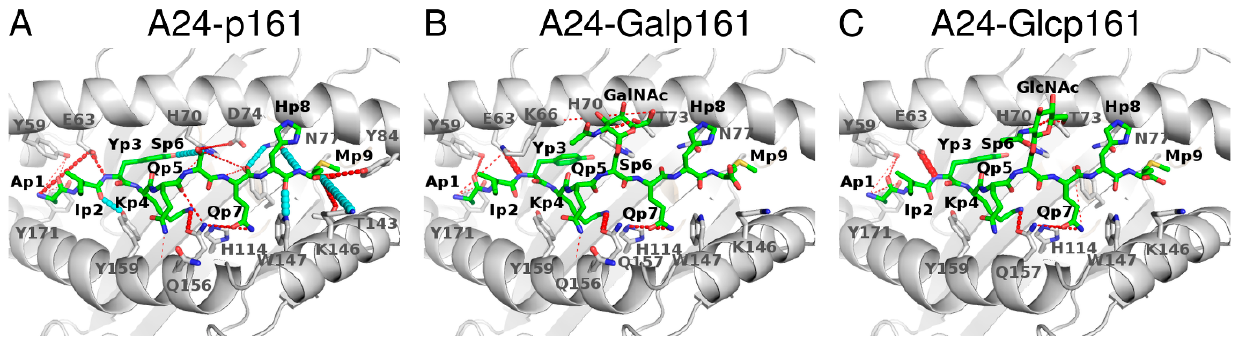
Figure 3. Hbond interactions between A24 and the p161 peptides during the 300–500 ns part of the MD simulations: ( A ) p161, ( B ) Galp161, and ( C ) Glcp161. A24 is in grey ribbons, the interacting residues from A24 are in sticks, the peptides are in green sticks with Oxygen atoms in red and Nitrogen atoms in blue. Hbonds that are present in all three complexes with a lifetime > 10% are shown as dashed cyan lines in only A24-p161 and not shown in the other panels for clarity. If an hbond has a lifetime difference between a glycosylated complex and a wild type complex higher than 10%, then that hbond is shown in dashed red lines. The thickness of the dashed lines corresponds to the lifetime. In the case of multiple hbond donors and acceptors, as in Arg and Asp, the atoms between the donor/acceptor atoms are used to show the hbonds.